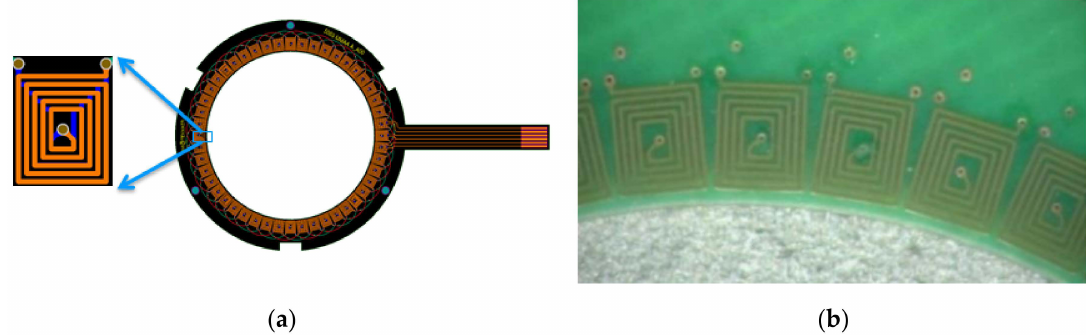
Figure 4. Three-phase generator PCB. ( a ) PCB design. ( b ) Manufactured coils and connection drills.